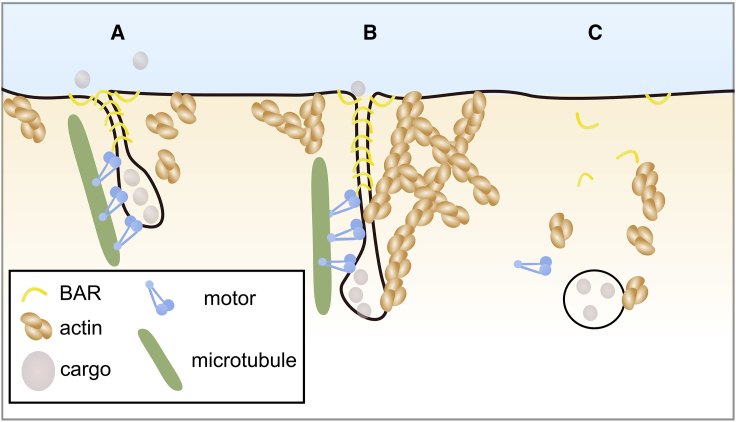
Schematics of Endocytosis by FDSHypothetic role of FDS in vivo enabled by BAR domain scaffolding. (A) BAR domain proteins, such as endoA2, bind to the cytosolic leaflet of endocytic membrane invaginations, forming a scaffold. The membrane tube containing cargoes is extended by microtubule-based molecular motors, such as dyneins or kinesins. (B) Tube elongation is aided by actin polymerization, up to the point at which FDS occurs. (C) Eventually, the BAR domain proteins, the motors, and actin disassemble from the endocytosed vesicle, which continues along the endocytic pathway.